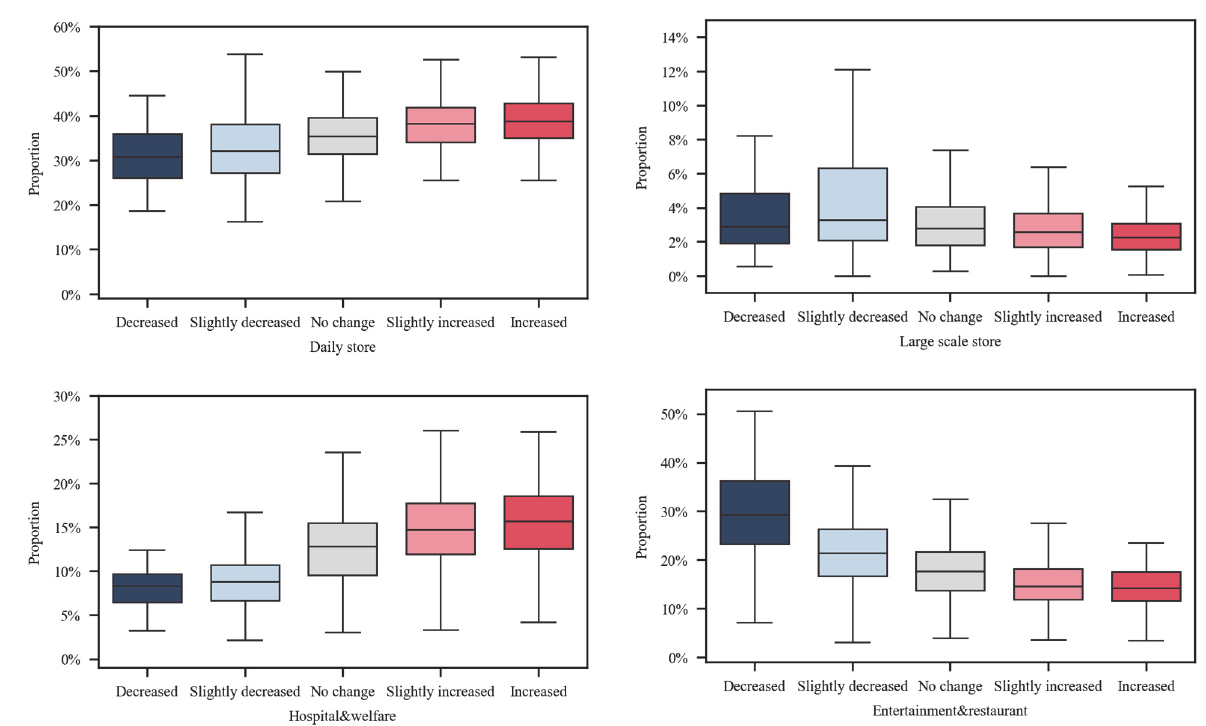
Figure 11 . The proportion of commercial facility categories according to change